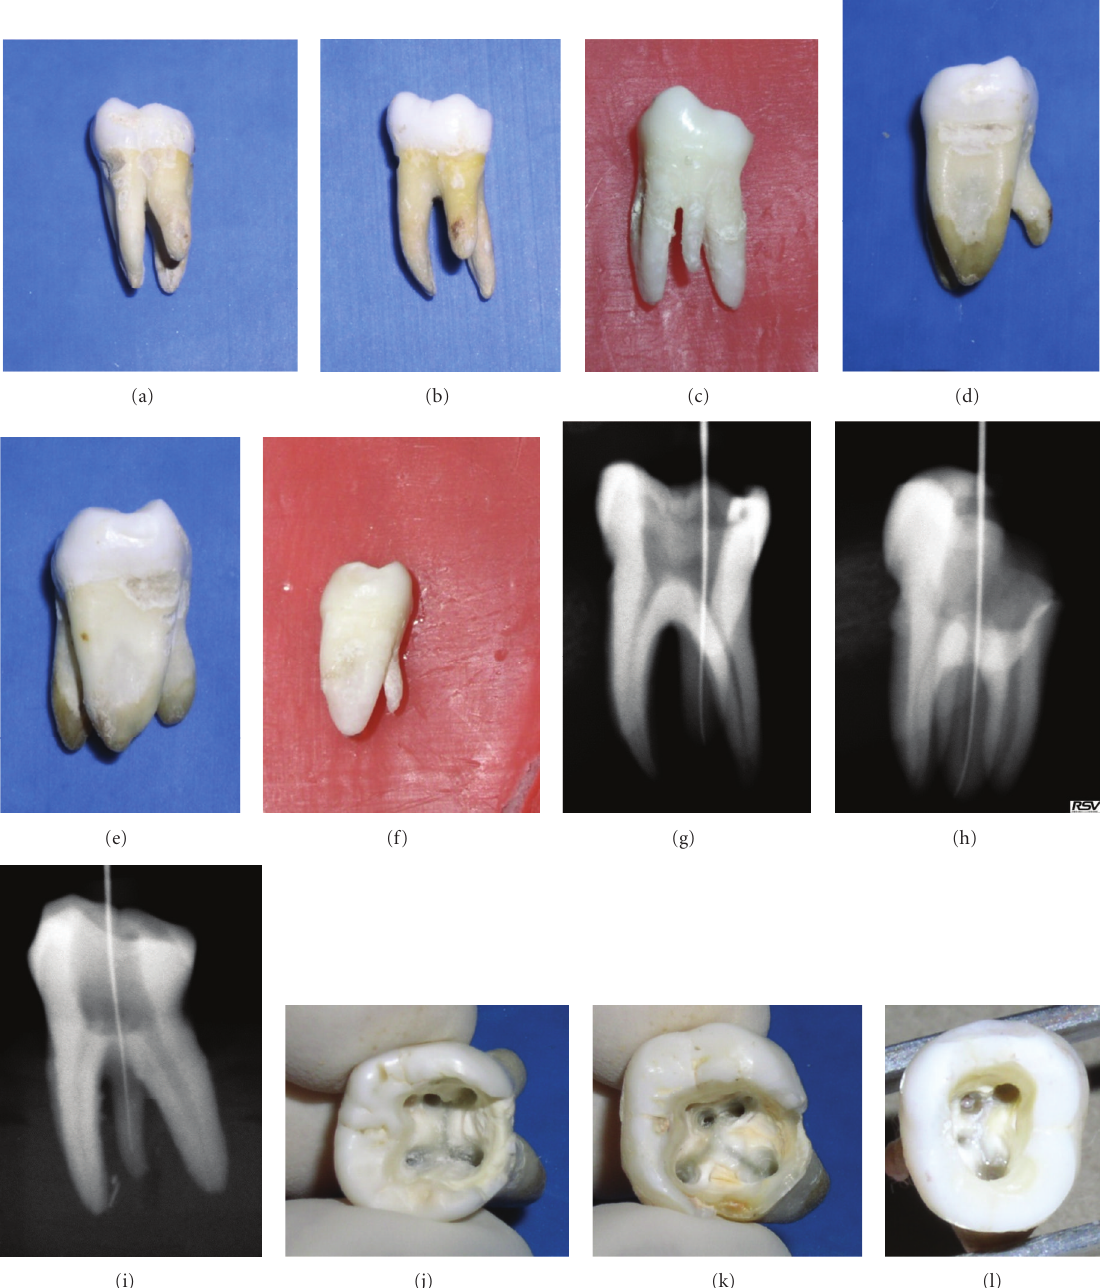
Figure 4: (a, e, and i) Lateral view of the extracted teeth, (b, f, and j) mesial view of the extracted teeth, (c, g, and k) access cavity preparation, and (d, h, and l) radiographic